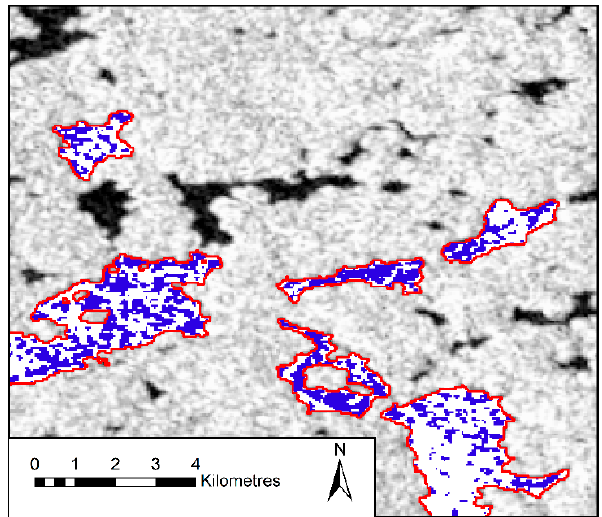
Figure 13. The threshold-based method did not successfully capture the freezing event on February 19th due to the restrictions of the filter. The blue pixels indicate that a melt event was detected and the white pixels indicate that no event was detected. RADARSAT-2 Data and Products © MacDonald, Dettwiler and Associates Ltd. (2017)—All Rights Reserved.